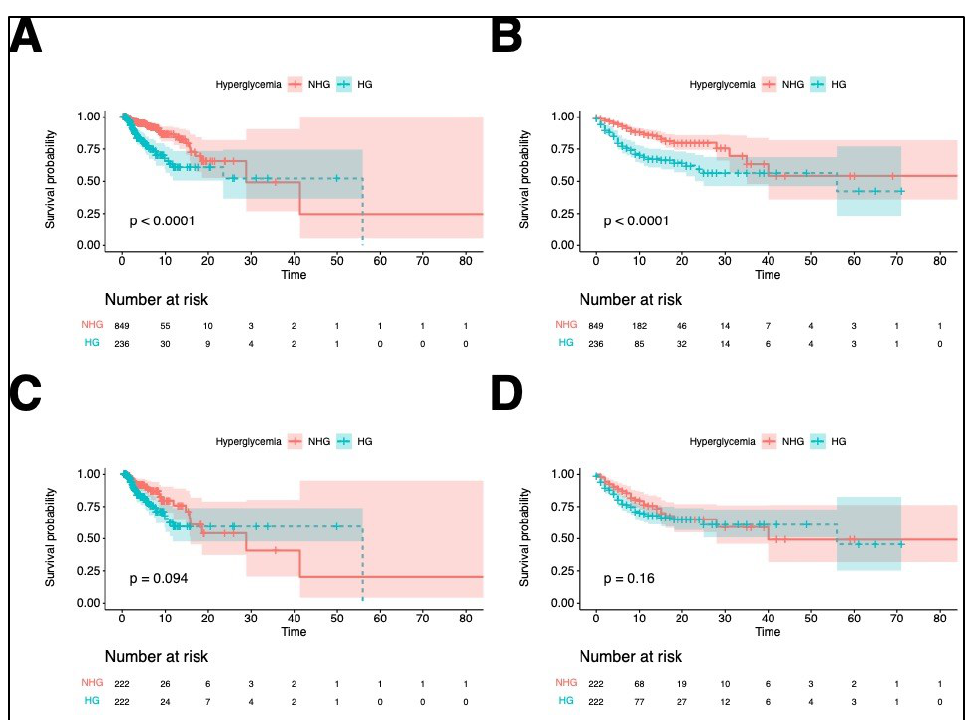
Figure 4. Kaplan–Meier survival curves until intensive care unit (ICU) discharge and hospital discharge. ( A ) ICU mortality before propensity score matching (PSM); ( B ) in-hospital mortality before PSM; ( C ) ICU mortality after PSM; ( D ) in-hospital mortality after PSM. The colored areas describe the standard deviation. ICU, intensive care unit.